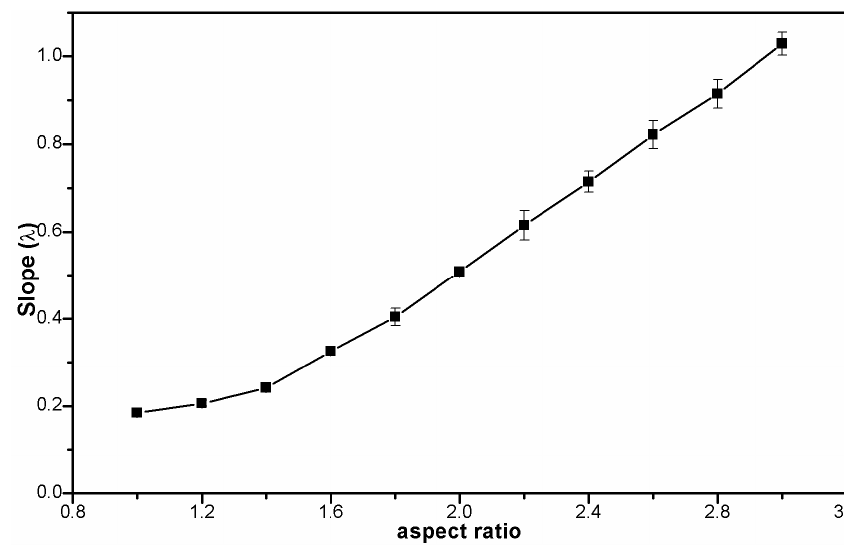
Figure 9. Dynamic changes in slope ( λ ) with different aspect ratios (with error bars). Table 3. Fitting parameters of the simulation cases.